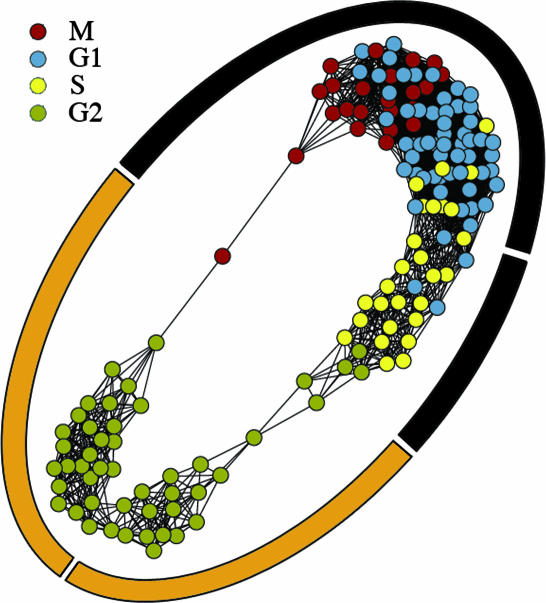
Network of 156 Genes Identified as Periodically Regulated in the Three Studies (~10% of the Entire Pool)The black–orange circle provides a visual identification of the two main clusters (the black one and the orange one) and of the relative hierarchical subclusters. This image has been realized with the graph drawing software Visone [30].